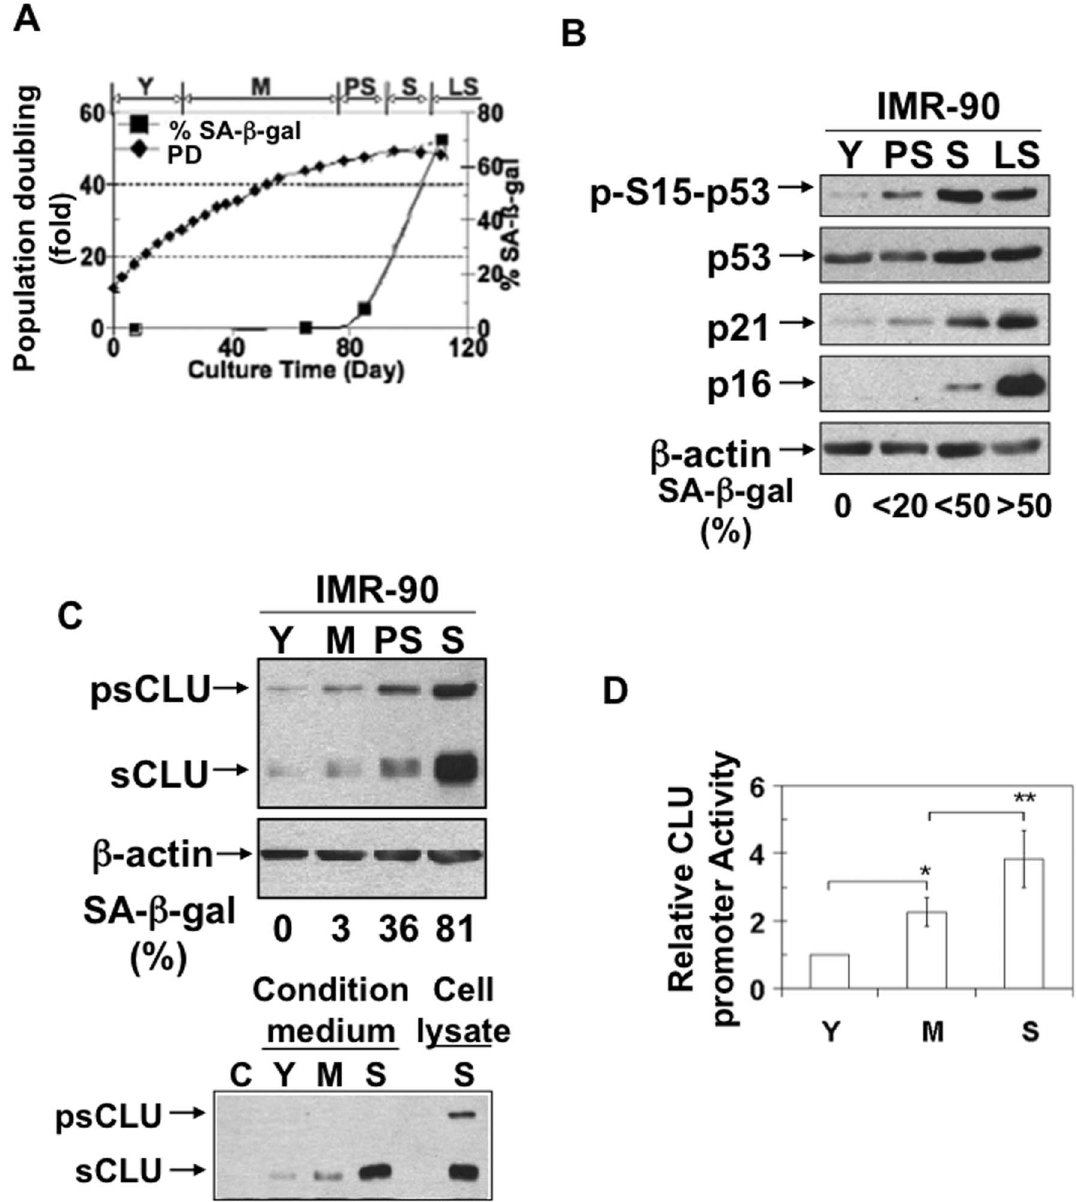
Figure 1. sCLU expression is increased during senescence. Young (Y), middle-age (M), premature-senescent (PS), senescent (S), and late senescent (LS) IMR-90 cells were generated by continuous culture. (A) The ‘‘age’’ of the IMR-90 cells was determined by population doublings and %SA- b -gal + cell measurements. Experiments were repeated three or more times in triplicate each, and representative results are shown. (PD, population doubling). (B) Senescence markers, phospho-ser15-p53, total p53, p21 and p16 levels, were markedly increased during senescence. (C) Both the precursor (psCLU) and the mature secretory (sCLU) forms of clusterin were induced in total cell lysates during senescence. sCLU levels increased in the media of senescent IMR-90 cells. (D) The promoter activity of sCLU was increased during senescence. *, p-value # 0.05, **, p-value # 0.01.